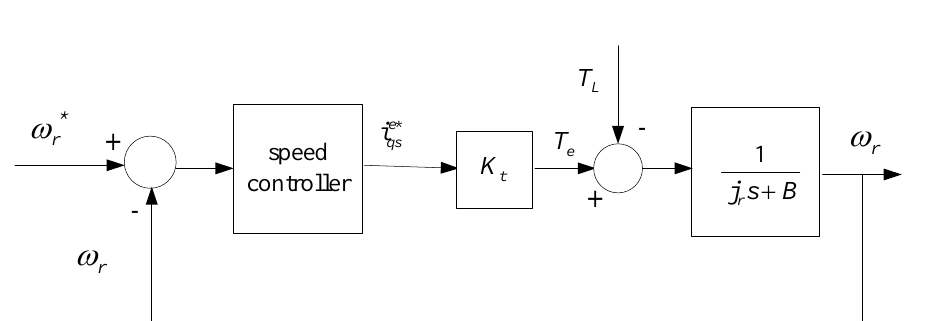
Figure 2. Block diagram of simplified IFOC of